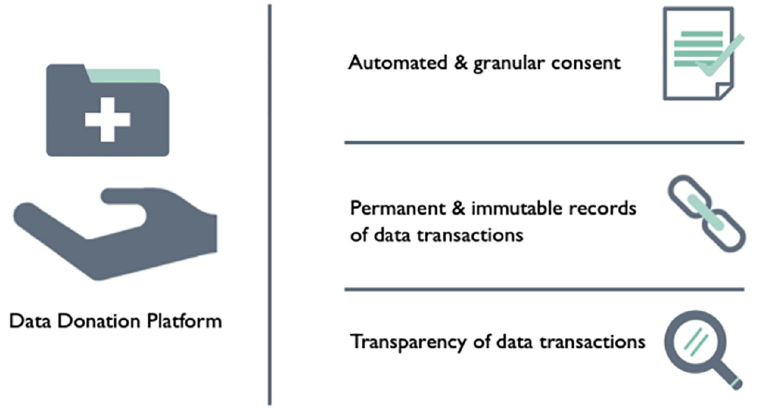
Fig 3. Data donation scenario blockchain feature summary slide. This slide was presented to a subset of participants during the focus group to summarise the blockchain features of the data donation scenario with the following script: “1. Automation & granular consent: Patient information exchanged via the CDIP platform can be de-identified and permission to access this can be granted through smart contracts. This consent is a digitally encoded agreement between two people in the form of computer code which will only be executed if a number of conditions are met. For example, Chris can decide and say that his GP can access his Fitbit data, but pharmaceutical companies cannot. For example, a smart contract might be written to automatically enable healthcare professionals to access a patient’s medical record only if certain conditions are met: (1) that the patient has consented Healthcare Professionals (HCP) access and (2) the HCP can prove authority to access confidential patient files. 2. Immutability: Transactions on the blockchain are permanently recorded. For example, this makes it almost impossible for a user to alter details of a person’s medical history or the results of a clinical trial. 3. Transparency: Personal data will NOT be stored directly on the CDIP platform but ‘pointers’ of all data transactions will allow any users to be able to trace the flow of data between different entities. Transactional data stored on the blockchain will be visible to all approved participants. You can see/ verify who is accessing your health data at every stage, for example if your doctors have accessed or viewed your data.”